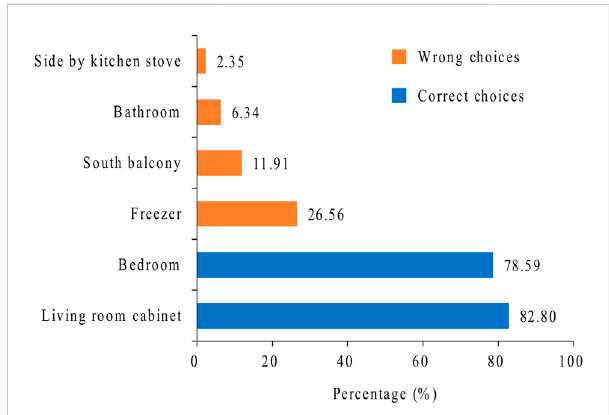
FIGURE 1 Storage place of inhaler devices after opening. The numbers indicate thepercentageoftheselection. The twobluestripsrepresent the correct choices.